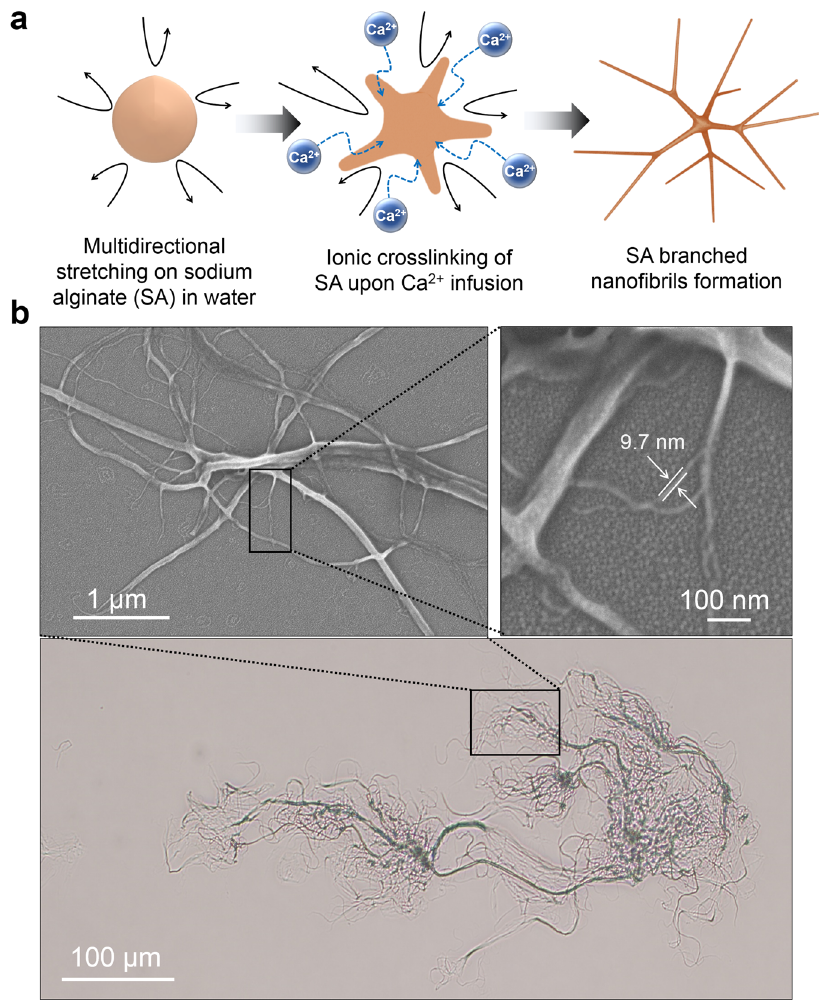
Fig. 1 Turbulent shear-driven precipitation and morphology of a sodium alginate soft dendritic colloid. a Schematic of the SA SDC formation process by precipitation in a turbulent medium. b Optical microscopy and fi eld emission scanning electron microscopy (FE-SEM) images of sodium alginate soft dendritic colloids. These images illustrate the hierarchical fi brillar morphology of the SDCs, which leads to high exclusion volume, strong van der Waals adhesiveness, and high propensity for